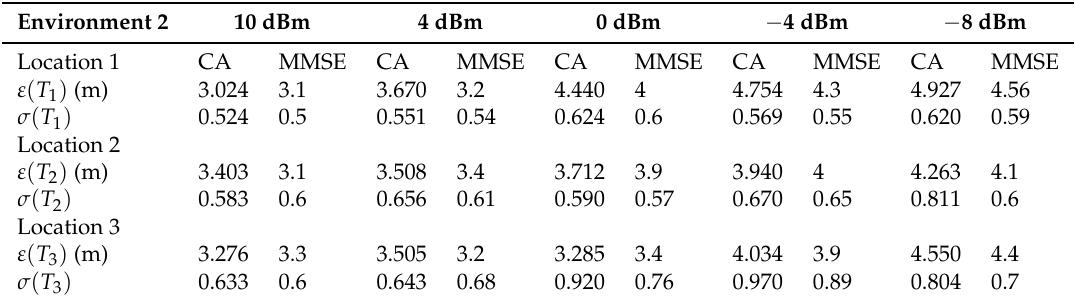
Table 6. Localization Accuracy and Localization Precision in Environment